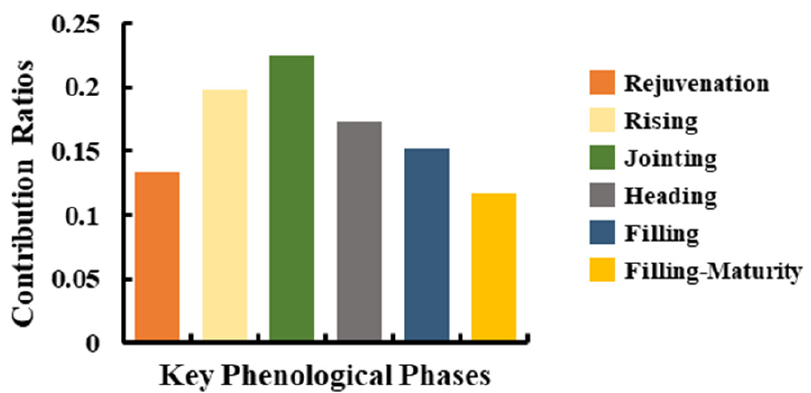
Figure 5. Contribution ratios of phenological phases in the study.